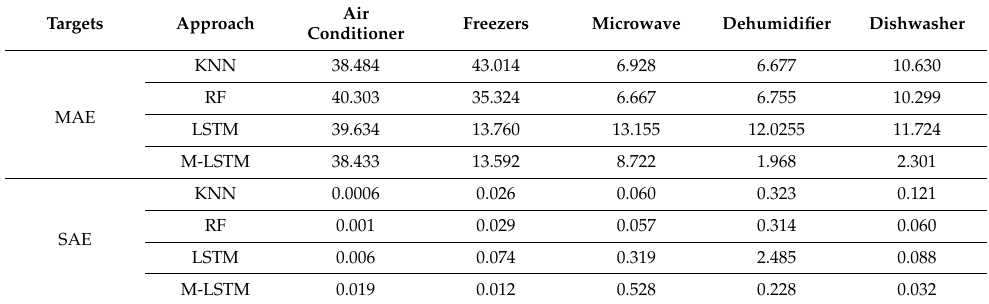
Table 1. Comparison of WikiEnergy 25 household load decomposition assessment